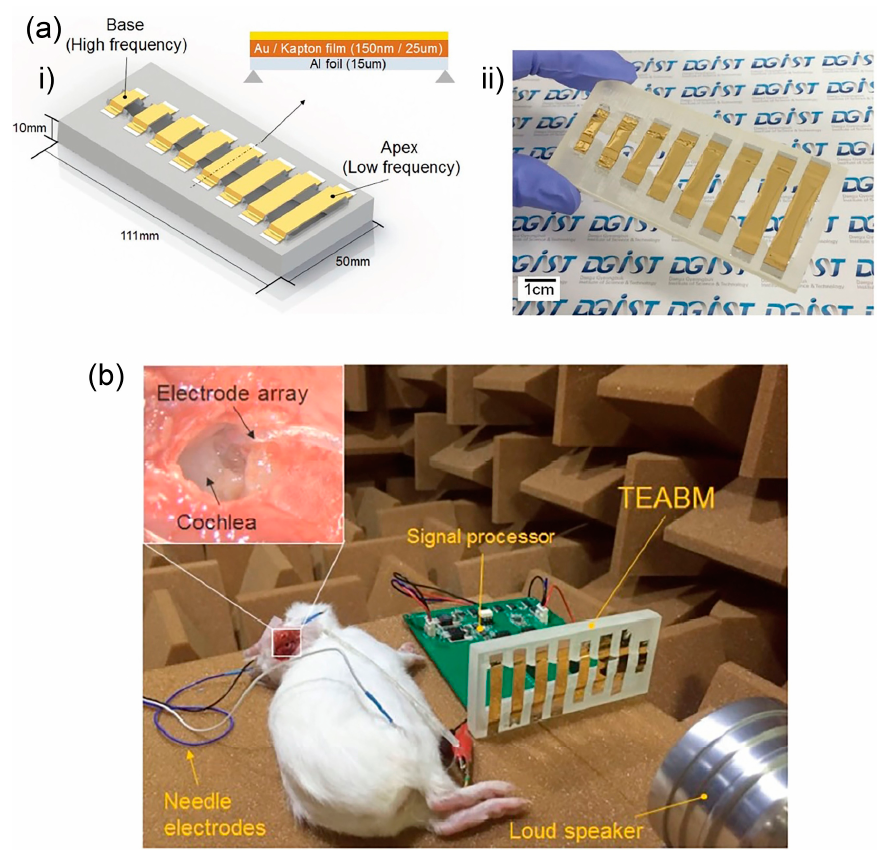
Figure 18. ( a ) (i) The schematic drawing and (ii) the optical image of eight Al/Kapton/Au beams on substrate. ( b ) The experimental setup for animal testing using the triboelectric acoustic sensor including the signal processor and the custom-made intra-cochlear electrode array